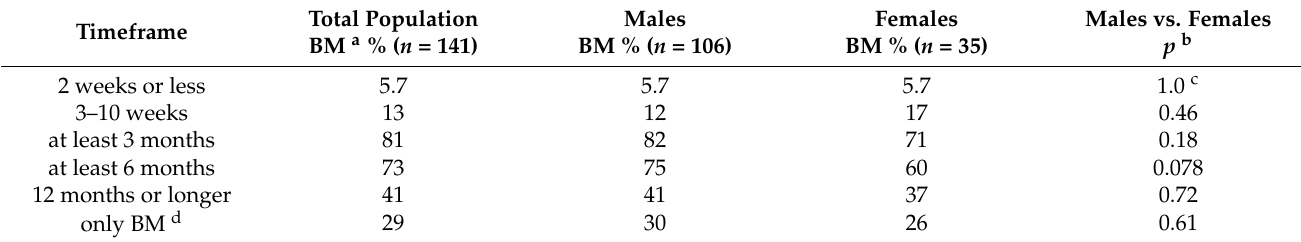
Table 1. Timeframe for any breastfeeding in FXS study population.